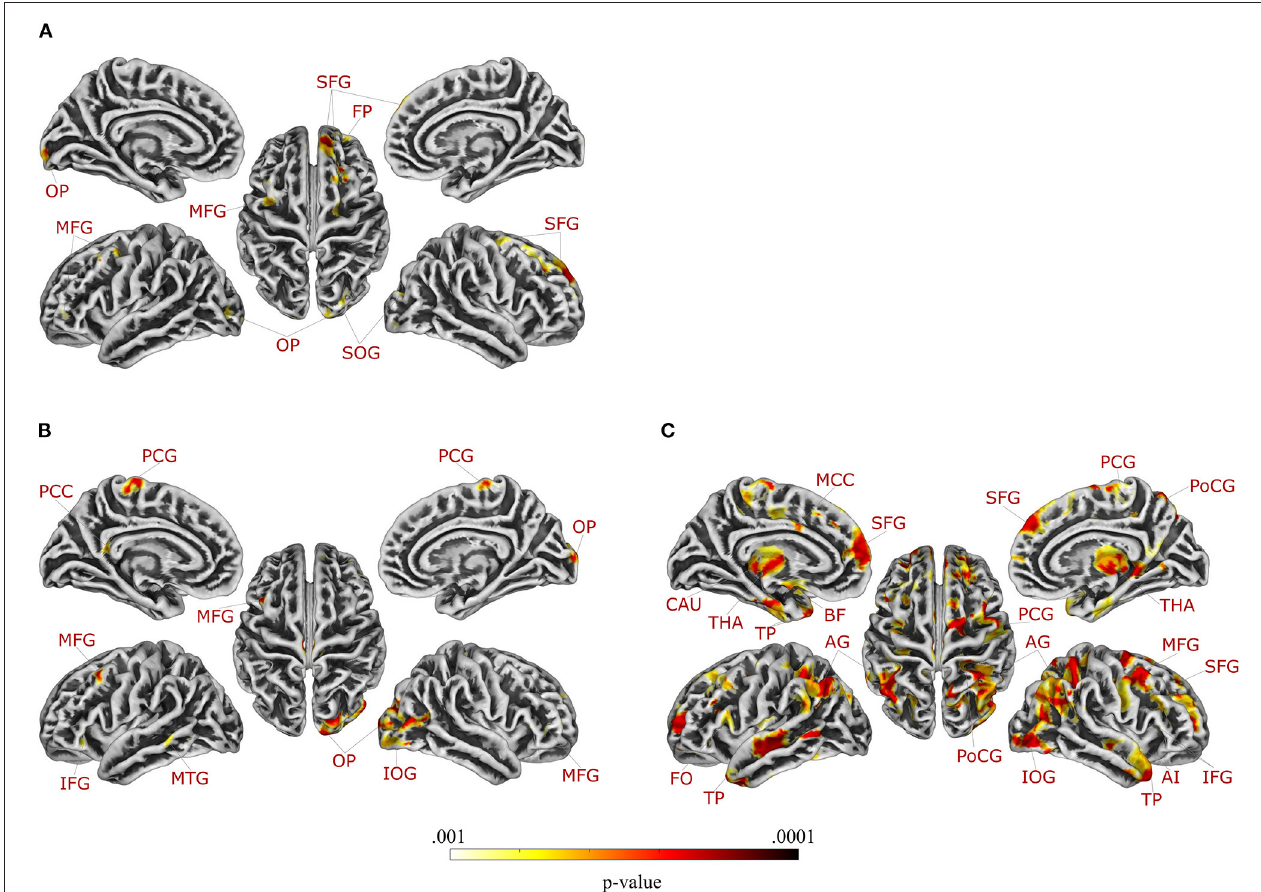
FIGURE 2 | Regions in which gray matter volume was differentially correlated with gastrointestinal symptoms in patients with (A) ulcerative colitis and (B) irritable bowel syndrome compared to healthy controls, and (C) regions in which gray matter volume was differentially correlated with chronic stress in patients with irritable bowel syndrome compared to healthy controls (applying a significance level of p < 0.001, uncorrected for multiple comparisons). Axial slices are provided in Supplementary Figures 5–7 . For details, see Tables 3 , 4 . AI, anterior insula; AG, angular gyrus; BF, basal forebrain; CAU, caudate nucleus; FO, frontal operculum; FP, frontal pole; IFG, inferior frontal gyrus; IOG, inferior occipital gyrus; MCC, middle cingulate gyrus; MFG, middle frontal gyrus; MTG, middle temporal gyrus; OP, occipital pole; PCC, posterior cingulate gyrus; PCG, precentral gyrus; PoCG, postcentral gyrus; SFG, superior frontal gyrus; SOG, superior occipital gyrus; THA, thalamus; TP, temporal